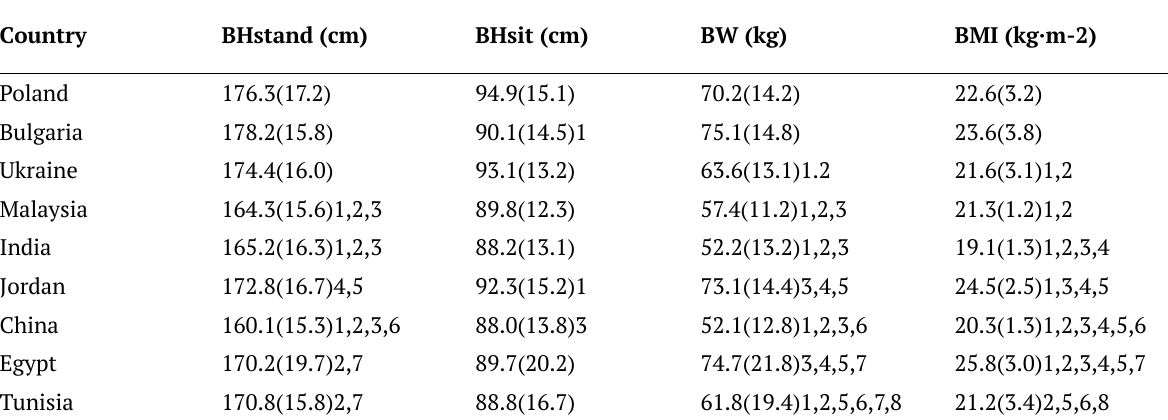
Table 2. Anthropometric indicators of students, X̄ (SD)